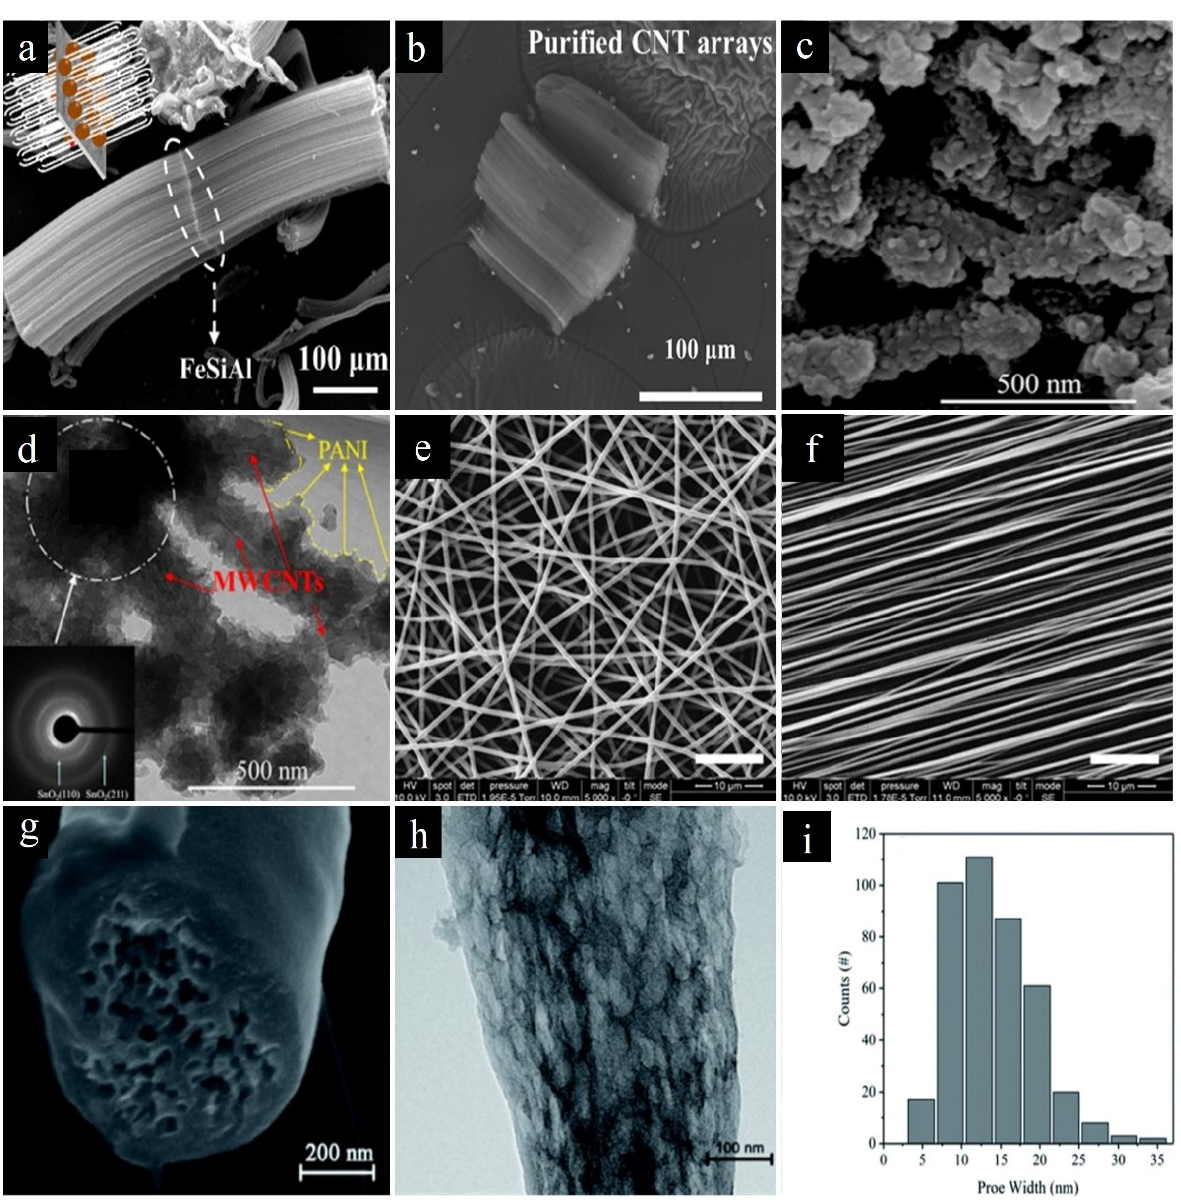
Figure 2g–i. The specific capacitance and area capacitance for HPCNFs were up to 327 F g − 1 and 80.5 mF cm − 2 , respectively.